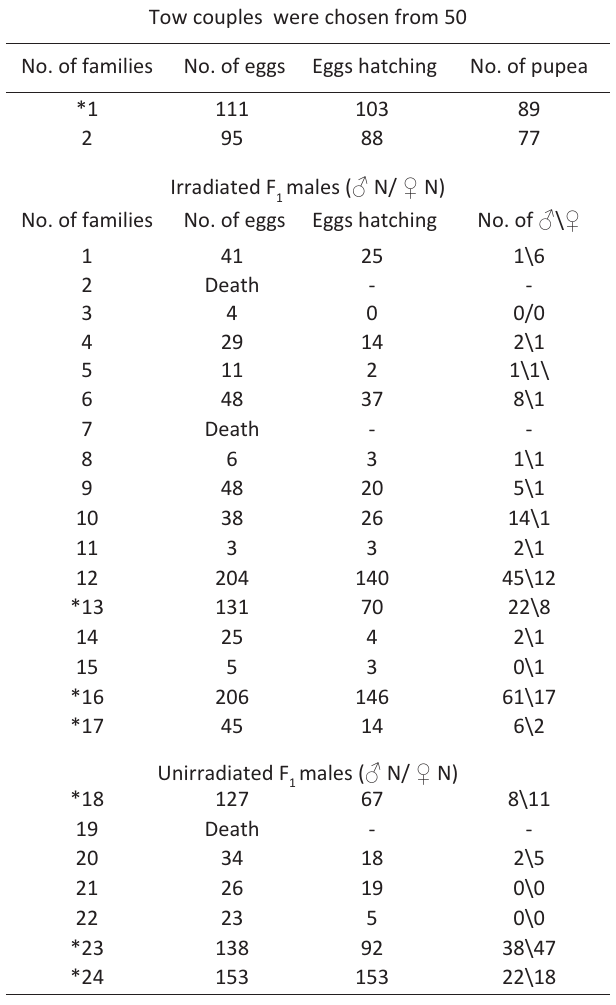
Table 2 - Inherited sterility technique experiments and the fami- lies of F generations selected for AFLP 1